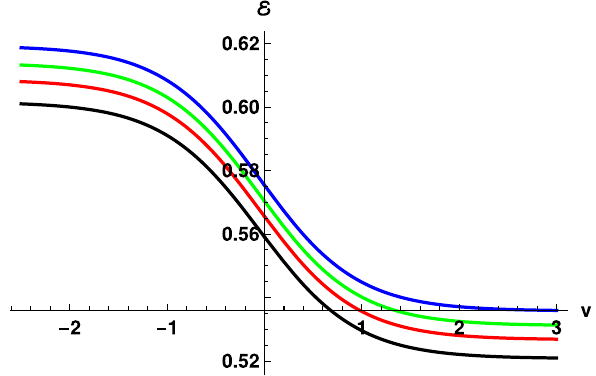
Fig. 2 Plots of entanglement negativity E vs. light cone time v for ( l 1 , l 2 ) = ( 0 . 50 , 0 . 50 ),( 0 . 45 , 0 . 55 ),( 0 . 43 , 0 . 57 ) and ( 0 . 41 , 0 . 59 ) , whichareshownbyblue,green,redandblackcurvesrespectively.Here, l s = 0 . 50, E is in units of 3 16 G ( 3 )